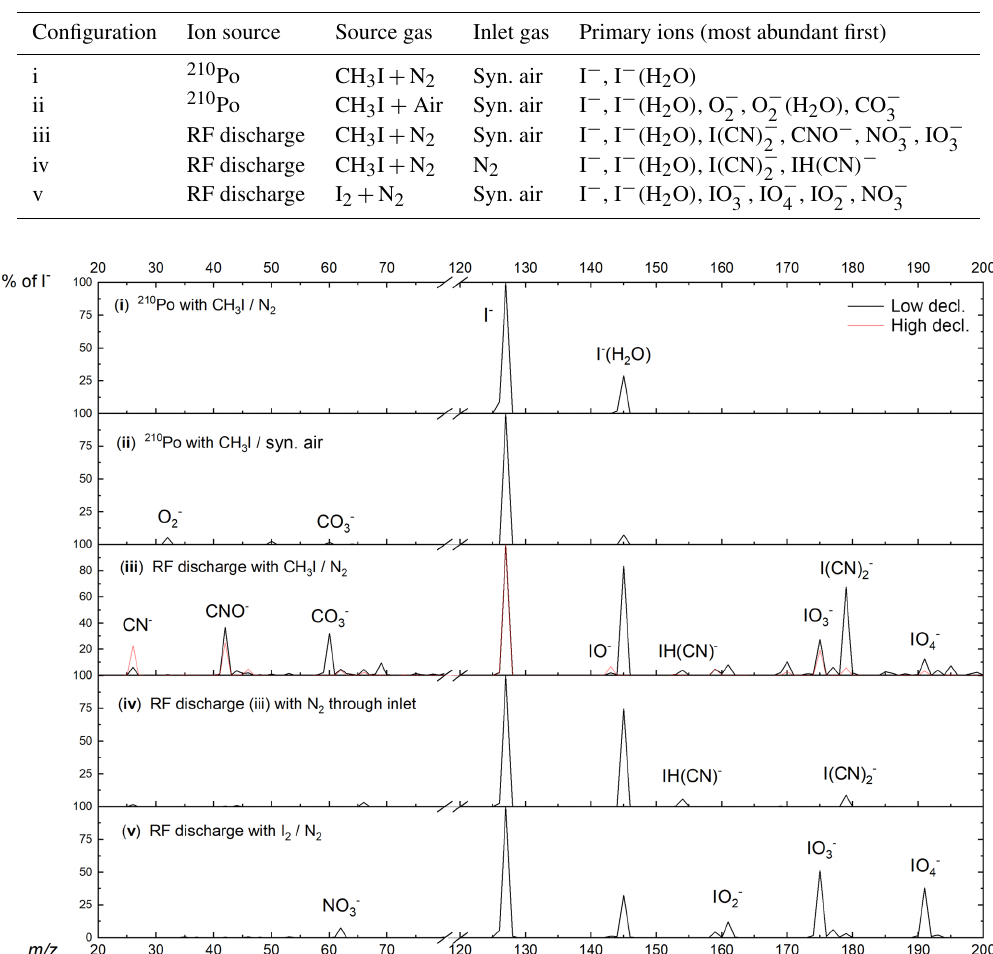
Table 1. Ion source configurations according to Fig. 3 and primary ions observed.